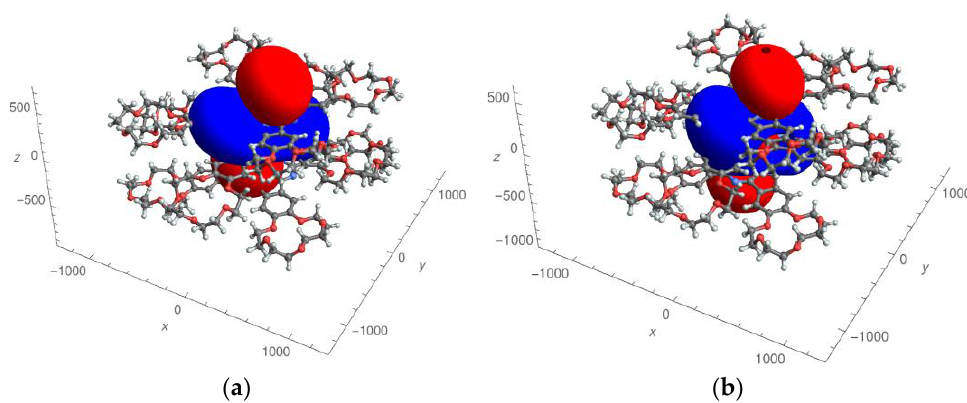
Figure 4. Effective field of pseudo-contact contributions to lanthanide-induced shifts in the Tb complex created by only one lanthanide cation ( a ) and two lanthanide cations ( b ). Areas with positive shift values are shown in red, and areas with negative shift values are shown in blue.